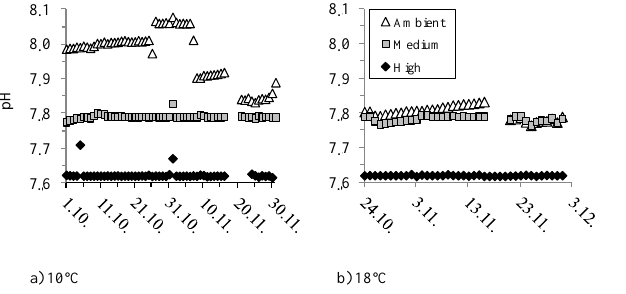
Fig. 2. Variation in pH in the larval phase run in ambient, medium Figure 2. p CO 2 and high p CO 2 at (a) 10 ◦ C and (b) 18 ◦ C in 2011. Ambi- ent is raw water from 90m depth. Note that the 10 ◦ C experiment started before 18 ◦ C.